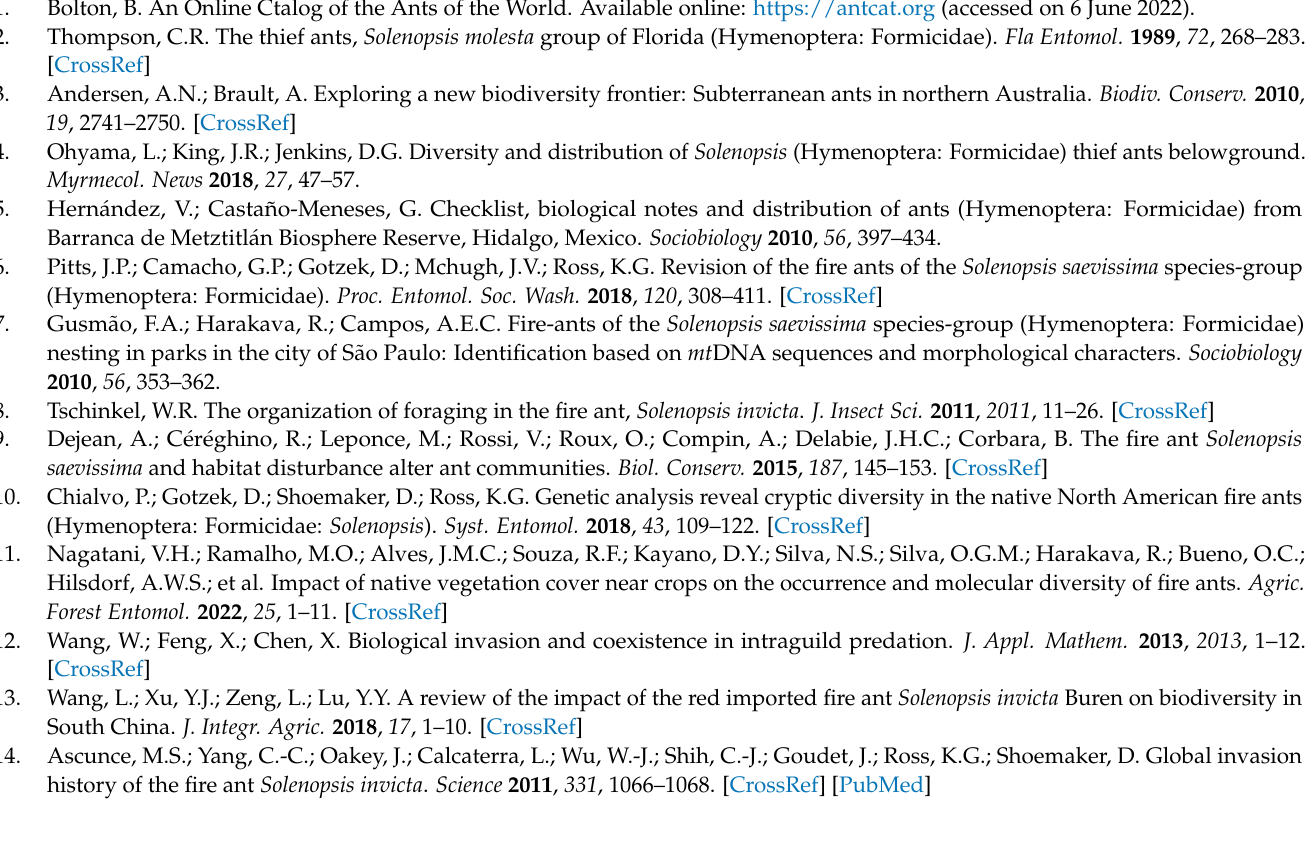
Table S1: Fire ants collected in the present study.; Figure S2: Photographs of Solenopsis invicta